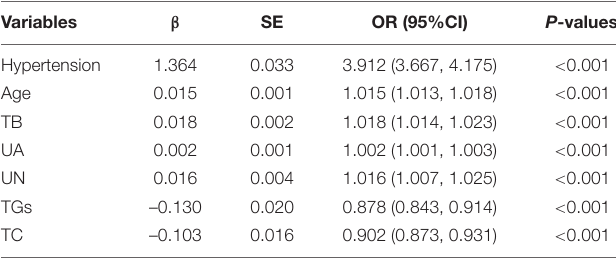
TABLE 3 | Univariate analyses of variables associated with HF. TABLE 4 | Results of multivariate logistic regression model.